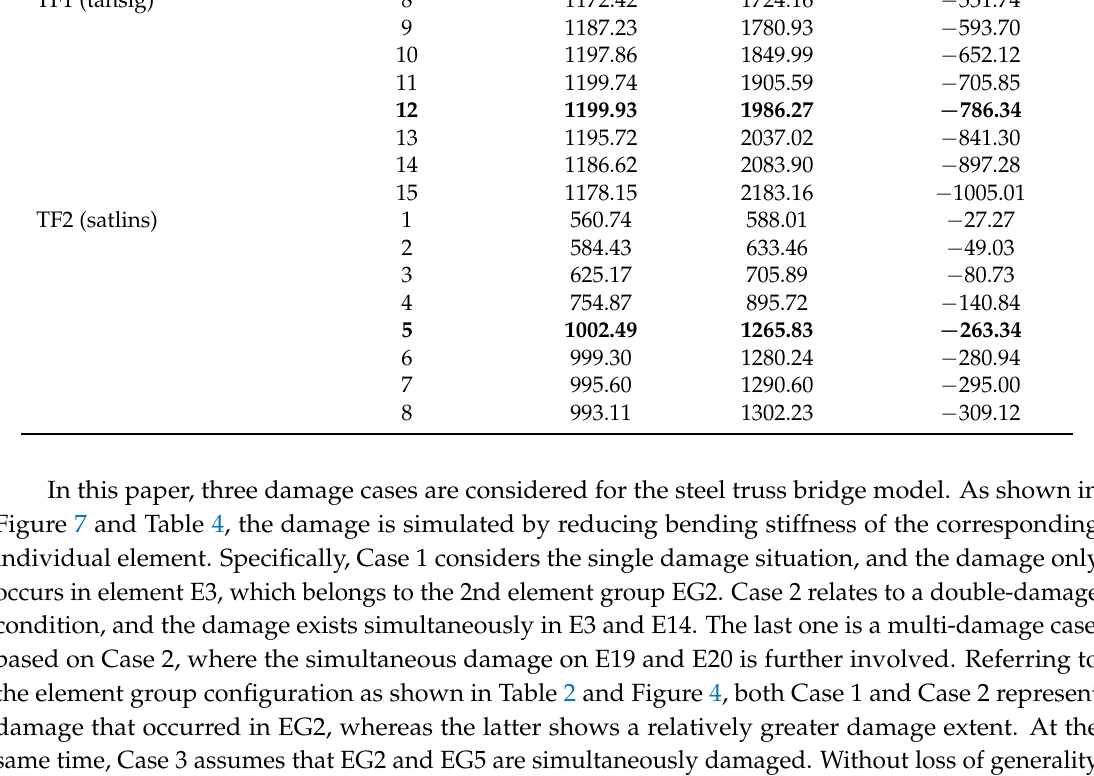
Table 4. Damage cases considered for the steel truss bridge model.